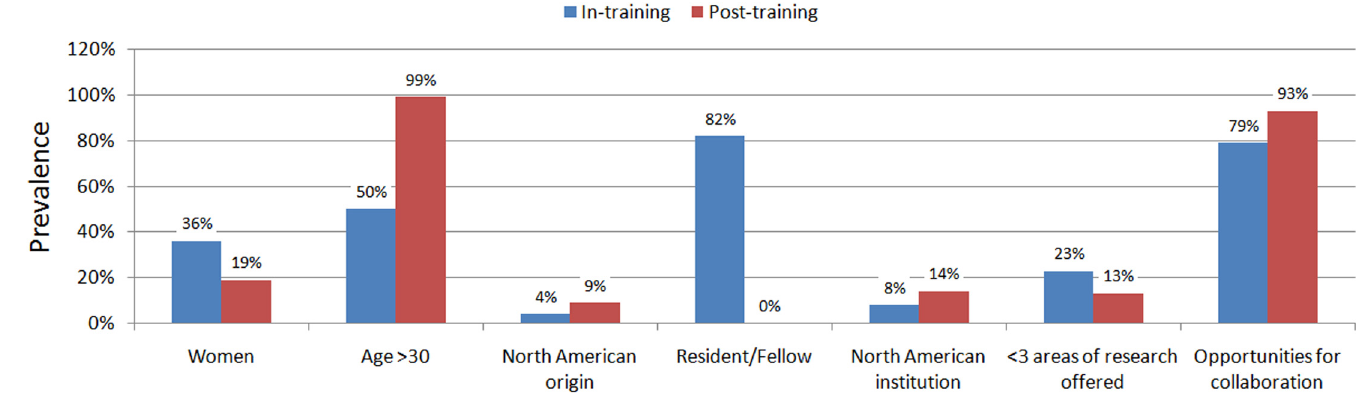
Fig 3. Key differences in replies according to phase of training of